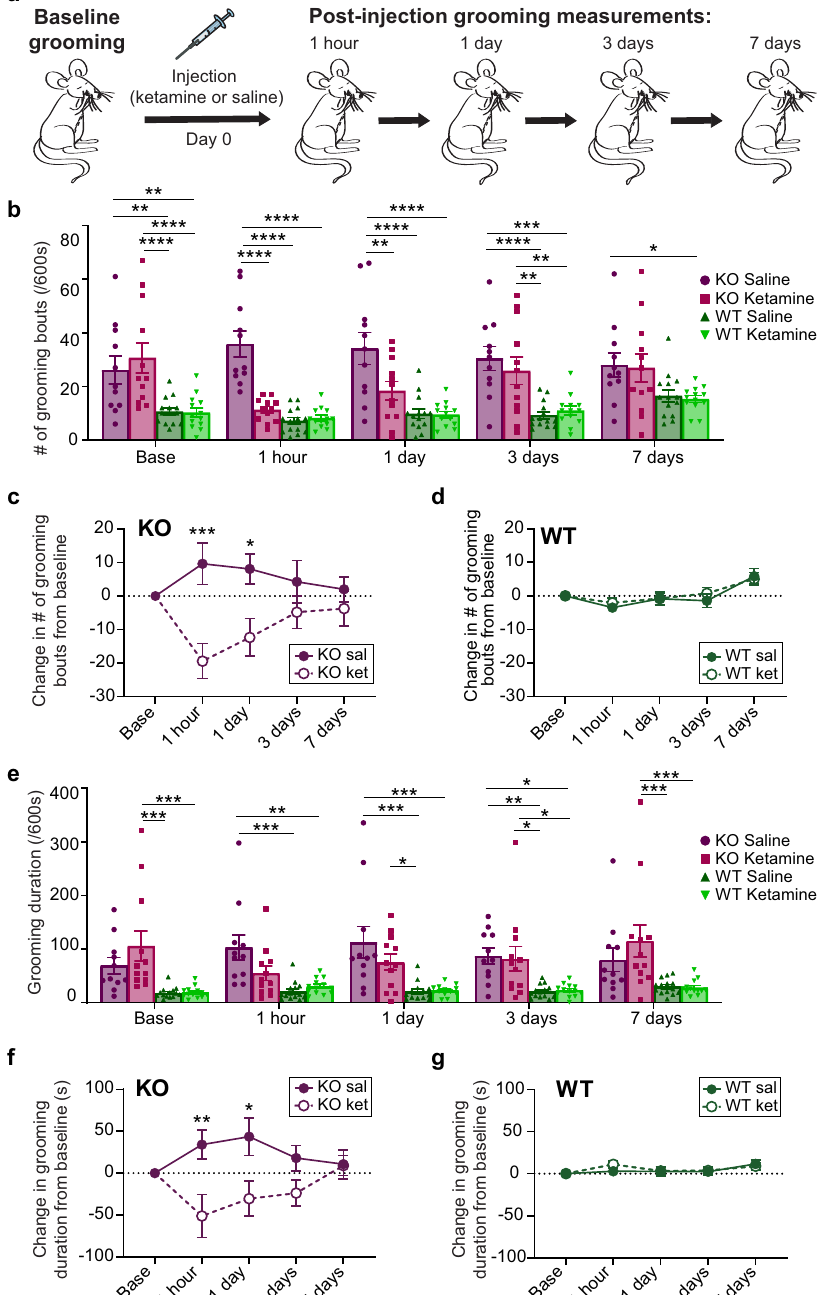
Fig. 2 Ketamine reduces compulsive grooming in SAPAP3 KO mice. a Schematic of experiment. b KO mice have higher baseline grooming frequency compared to WT controls. Ketamine reduces grooming frequency in KO animals 1-h and 1-day post-injection (two-way RM ANOVA: interaction P = 0.0002, time P = 0.0250, experimental group P < 0.0001, subject P < 0.001; signi fi cance derived from Tukey ’ s multiple comparisons are marked with asterisk(s); see Supplementary Fig. 4 for exact P values). c KO mice given ketamine have reduced grooming frequency compared to KO mice given saline (two-way RM ANOVA: interaction P = 0.0015, time P > 0.05, experimental group P = 0.0115, subject P <0.0001; Sidak ’ s multiple comparisons: 1-h timepoint P = 0.0002, 1-day timepoint P = 0.0138). d WT mice show no change in grooming frequency between treatment groups (two-way RM ANOVA: interaction P = 0.7892, time P < 0.0001, experimental group P = 0.7173, subject P < 0.0001). e Ketamine attenuates grooming duration in KO animals 1-h post-injection. Saline injection increases KO grooming compared to WT controls 1 h, 1 day, and 3 days post-injection (two-way RM ANOVA: interaction P = 0.0081, time P = 0.5614, experimental group P < 0.0001, subject P < 0.0001; signi fi cance derived from Tukey ’ s multiple comparisons are marked with asterisk(s); see Supplementary Fig. 4 for exact P values). f KO-ketamine mice have decreased grooming duration compared to the KO saline group (two-way RM ANOVA: interaction P = 0.0208, time P = 0.7935, experimental group P = 0.0040, subject P = 0.0864; Sidak ’ s multiple comparisons: 1-h timepoint P = 0.0026, 1-day timepoint P = 0.0120). g WT mice displayed no difference in grooming between treatment groups (two-way RM ANOVA: interaction P = 0.4333, time P = 0.0069, experimental group P = 0.7587, subject P < 0.0001). Bar and line graphs show data means + / − SEM. WT saline = 14, WT ketamine = 13, KO saline = 11, KO ketamine = 12. Source data are provided as a Source data fi le. * P < 0.05, ** P <0.01, *** P <0.001, **** P <